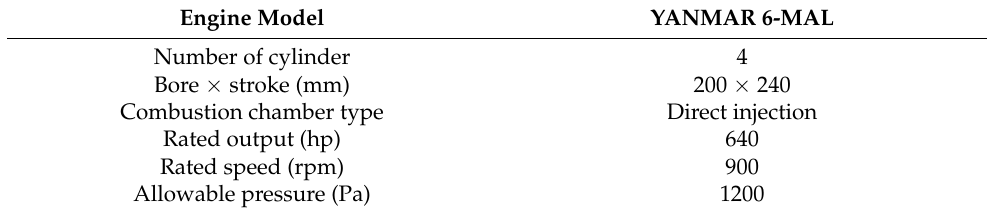
Table 2 shows the specifications of the target engine used in the study. Allowable pressure means the limit of engine back pressure (it was 1200 Pa). Table 2. Target engine Table 3 shows the calculation conditions used for flow analysis. Applied materials are ideal air, water liquid, and water vapor, and the phase change between water liquid and vapor was considered. The number of sprays was five, at a flow rate of 1.1 kg/s. The gas inlet flow rate was 0.55 kg/s and the temperature was 230 °C. The outlet was set equal